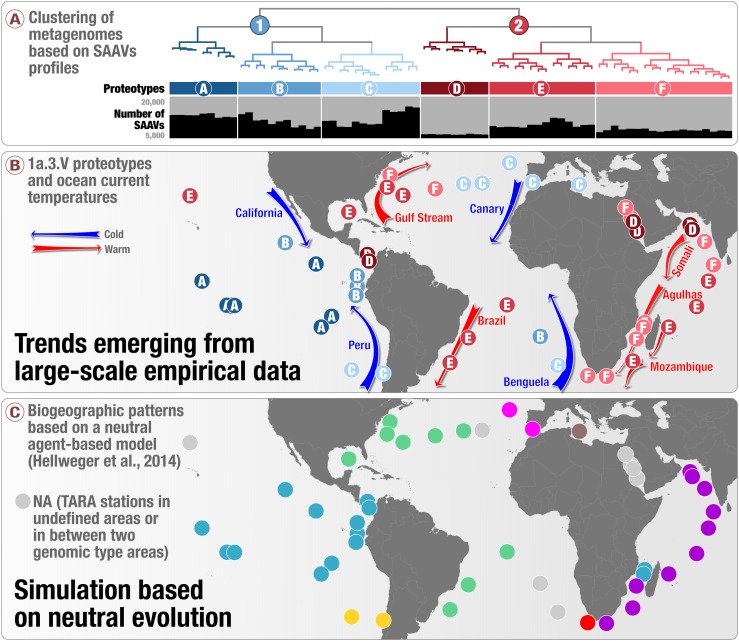
Geographic partitioning of SAR11 by matching surface metagenomes analyzed in our study to simulated results determined using a neutral-agent based model (Hellweger et al., 2014).The figure emphasizes biogeographic differences between this simulation focused on neutral evolution and our large-scale empirical analysis.